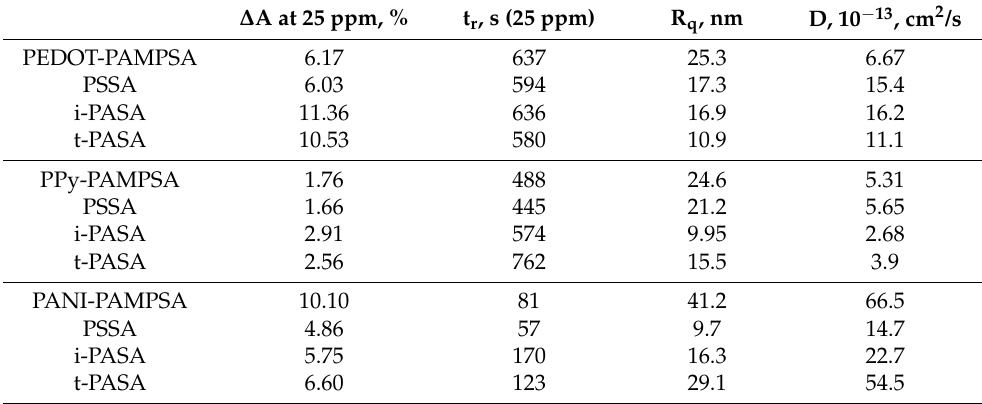
Table 1. Values of the sensor response amplitude ( ∆ A), response time (t r ) and diffusion coefficient (D) at 25 ppm of ammonia and the roughness (R q ) of films electrodeposited in the different medi- ums.